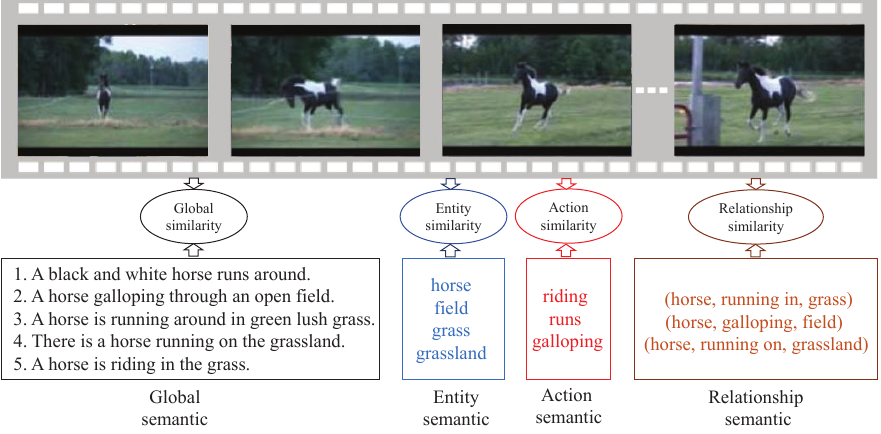
Figure 1. An illustration of both video and text are decomposed into global, entity, action and relationship semantic